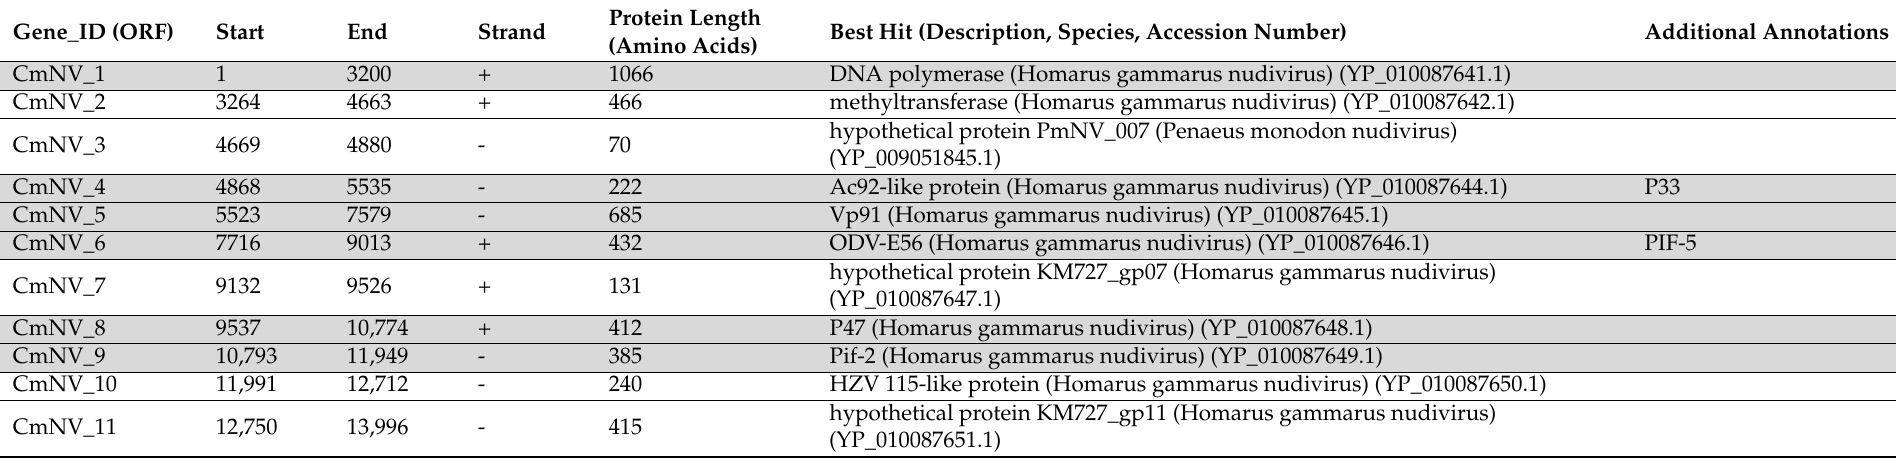
Table 2. Identified open reading frames (ORFs) in the CmNV genome. The start and end positions of the ORFs are shown, as well as the strand it was found on, the deduced protein length (in amino acids), the best hits obtained using blastp similarity searches using the NCBI nr protein database (E-value < 0.001), and additional information obtained from annotated orthogroups (Table S5). Nudivirus core genes are highlighted in